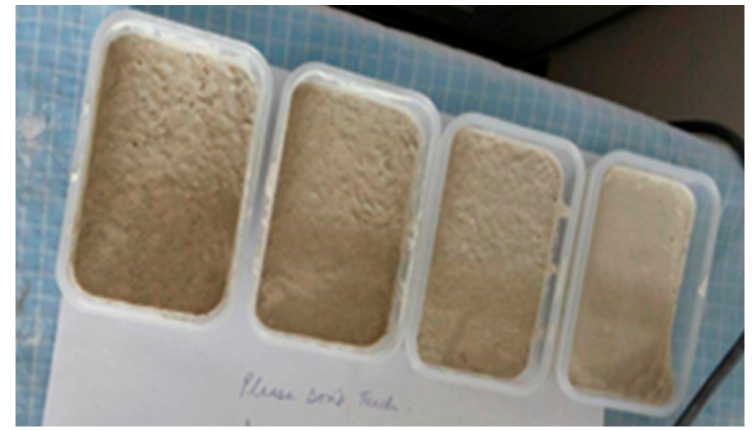
Figure 1. Samples prepared for tensile testing.